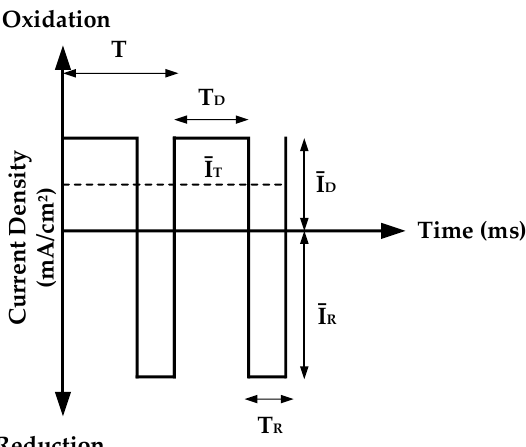
Figure 1. Current density-time diagram applied in pulsed electroplating method. ¯I R and ¯I D are reverse and direct current density, T R and T D are reverse and direct current application time, ¯I T is the average current density, and T is the duration of each periodicity.